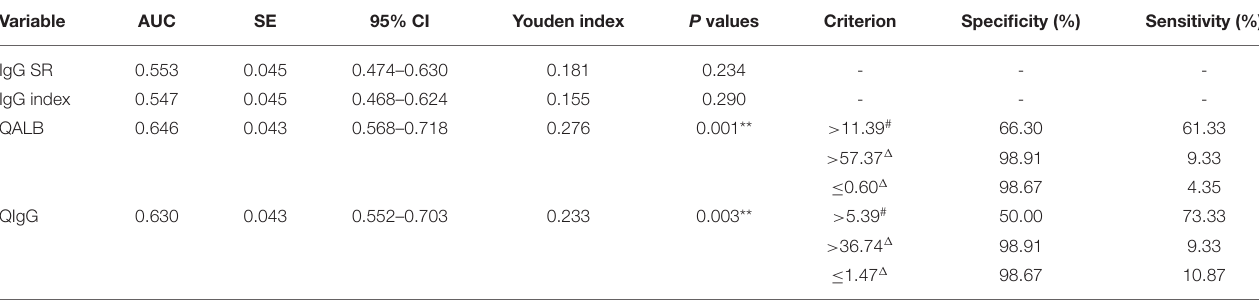
TABLE 5 | Analysis of the ROC curves of the IgG SR, IgG index, QALB and QIgG in the GBS and CIDP groups. Variable